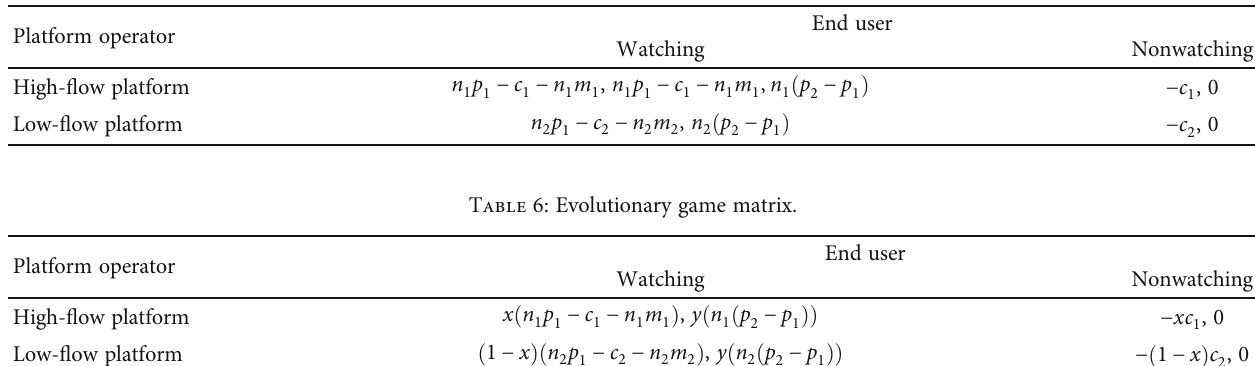
Table 5: Revenue matrix of platform partners and end users.